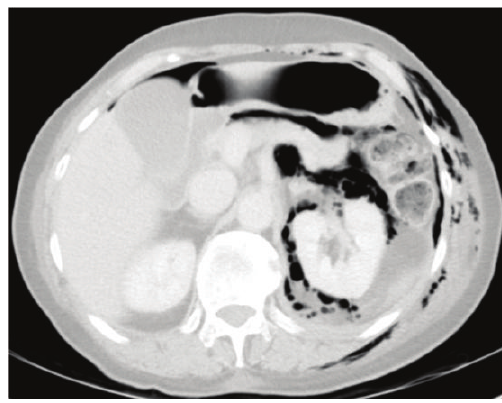
Figure 1: Abdominal axial computed tomography (CT) showing intraperitoneal free air following unrecognized bowel perforation.